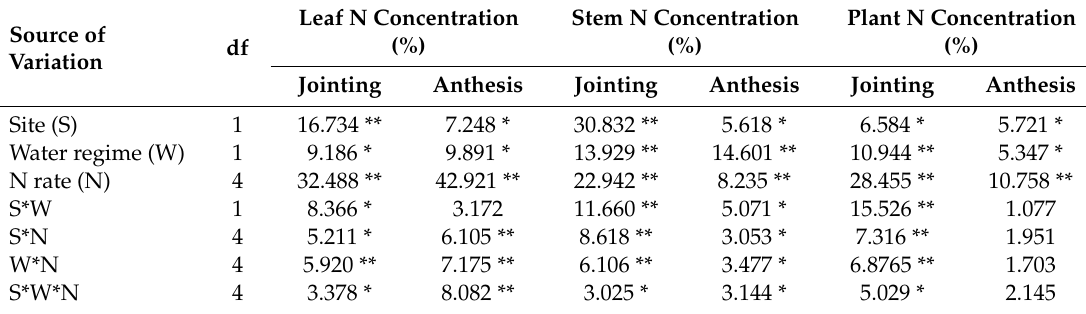
Table 4. The e ff ects of site, N rate, and water regime on tissue N concentration.